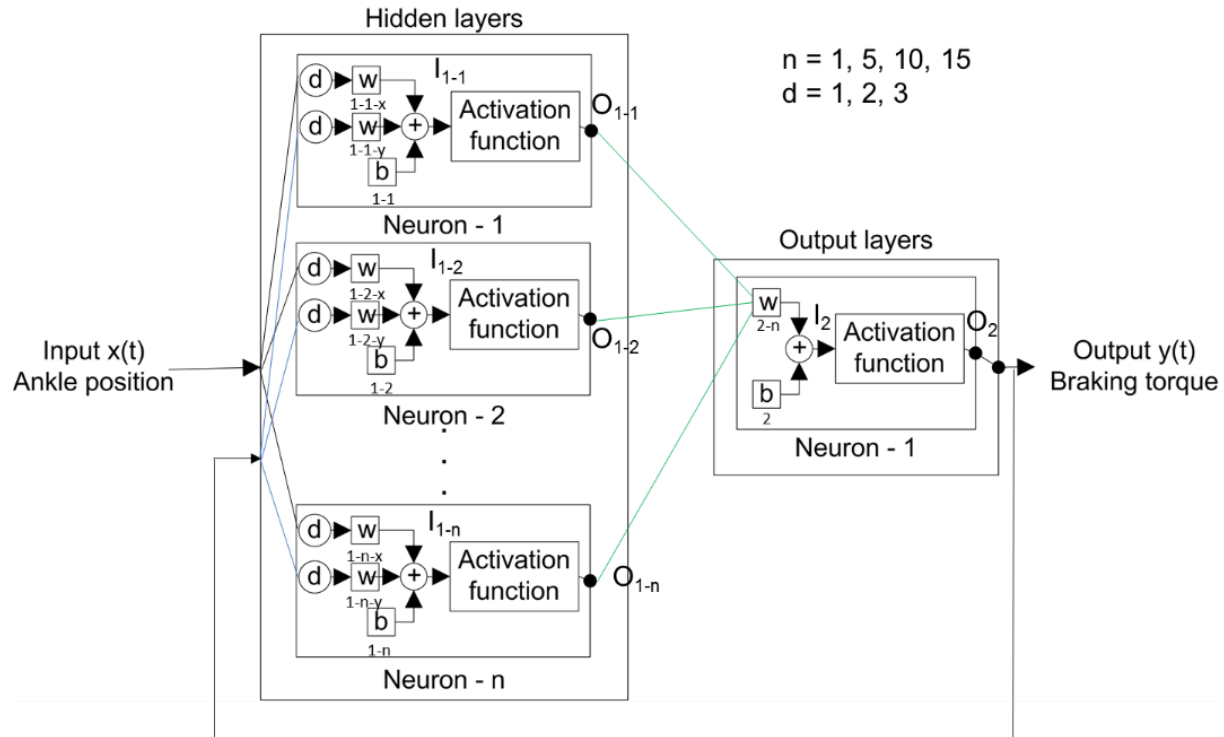
Figure 4: NARX neural network that is used in this